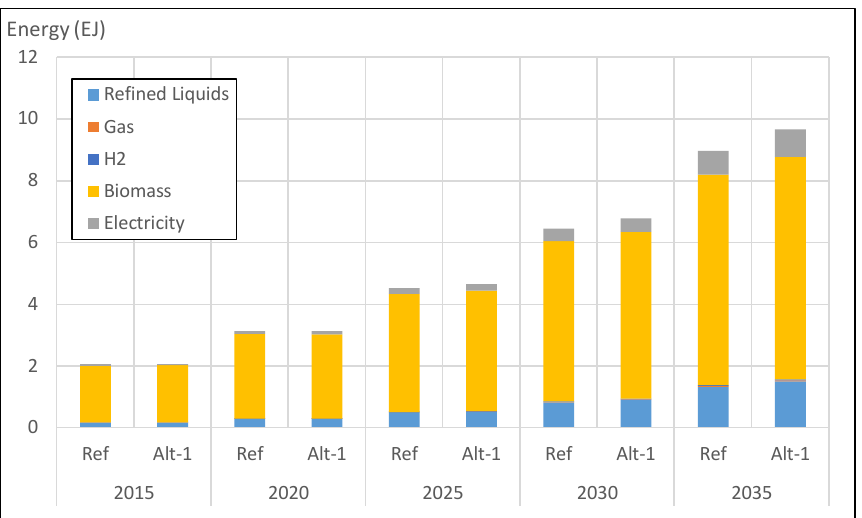
Figure 6. Final Energy Demand by GDP and Urban Population Scenario (Unit: EJ).